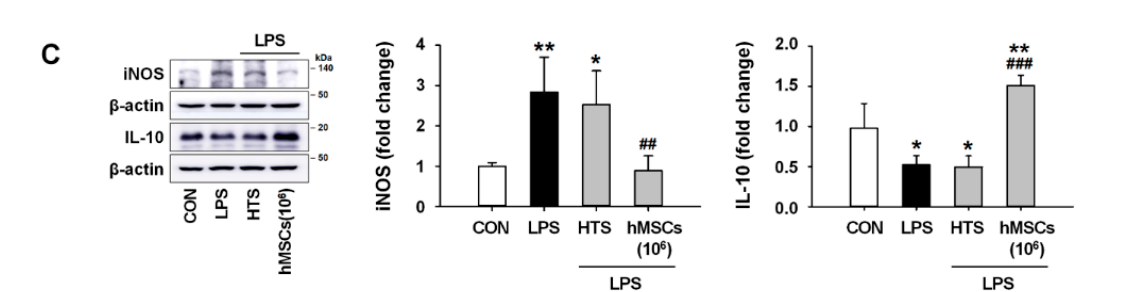
Figure 4. The immunomodulatory e ff ects of hMSCs on regulating microglia polarization in the cerebellum of ICA mice. ( A ) Double immunofluorescence staining for the expression pattern of Iba1 (microglia marker; green) and CD96 (M1-type microglia marker; red), or Iba1 (microglia marker; green) and CD206(M2-type microglia marker; red) in LPS-exposed cerebellum 7 days after hMSC treatment (Scale bar = 50 µ m). ( B ) Western blot analyses of the expression levels of CD86 and CD206 in the cerebellum of ICA mice at 7 days post-hMSC transplantation. * p < 0.05 vs. CON and # p < 0.05, ## p < 0.01, ### p < 0.001 vs. LPS ( n = 3 per group) ( C ) The expression levels of iNOS (M1 marker) and IL-10 (M2 marker) in the LPS-exposed cerebellum 7 days after hMSC transplantation by western blot